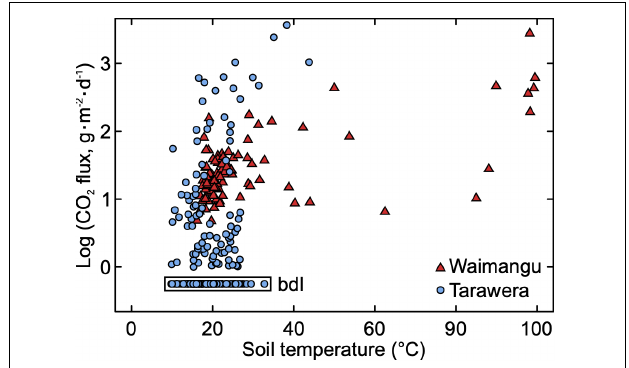
FIGURE 4 | Soil CO 2 flux against soil temperature at ∼ 1 m depth for Waimangu (red triangles) and ∼ 15 cm depth for Tarawera (blue circles). Data in the box are below detection limit (bdl, < 1 g · m - 2 · d - 1 CO 2